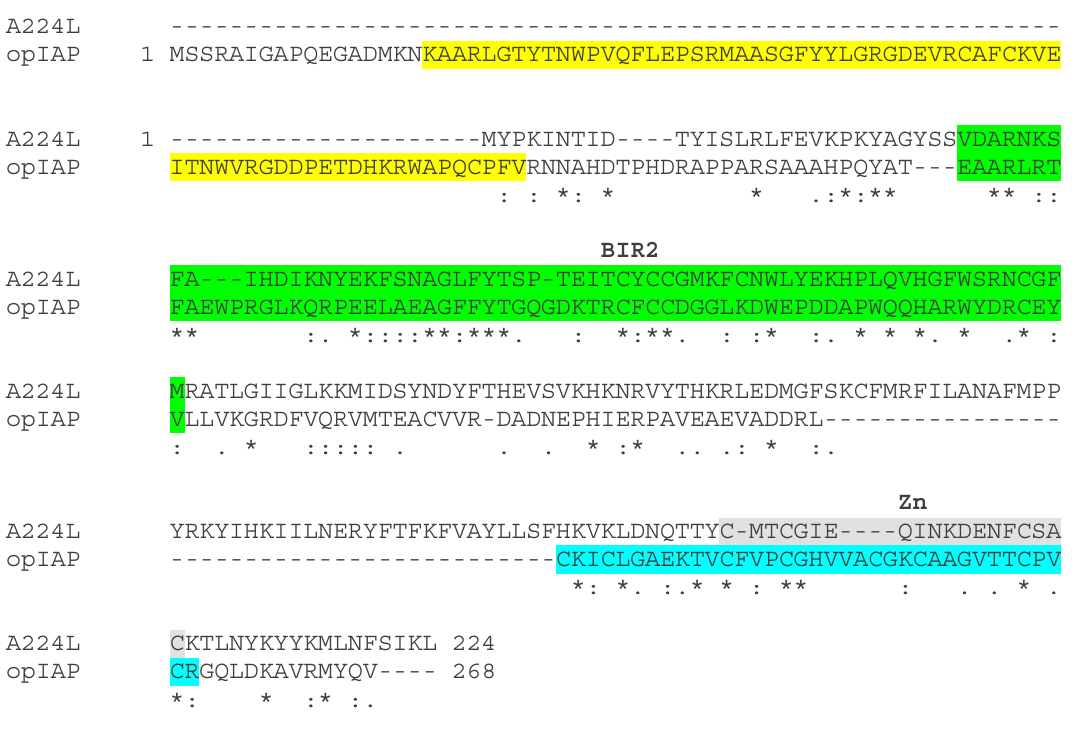
MRATLGIIGLKKMIDSYNDYFTHEVSVKHKNRVYTHKRLEDMGFSKCFMRFILANAFMPP VLLVKGRDFVQRVMTEACVVR-DADNEPHIERPAVEAEVADDRL----------------